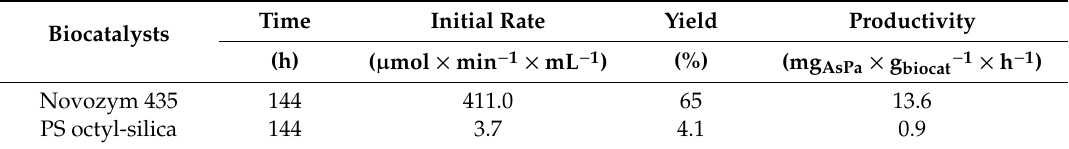
Table 2. Summary of parameters of synthesis of ascorbyl palmitate (AsPa) with the immobilized biocatalysts.